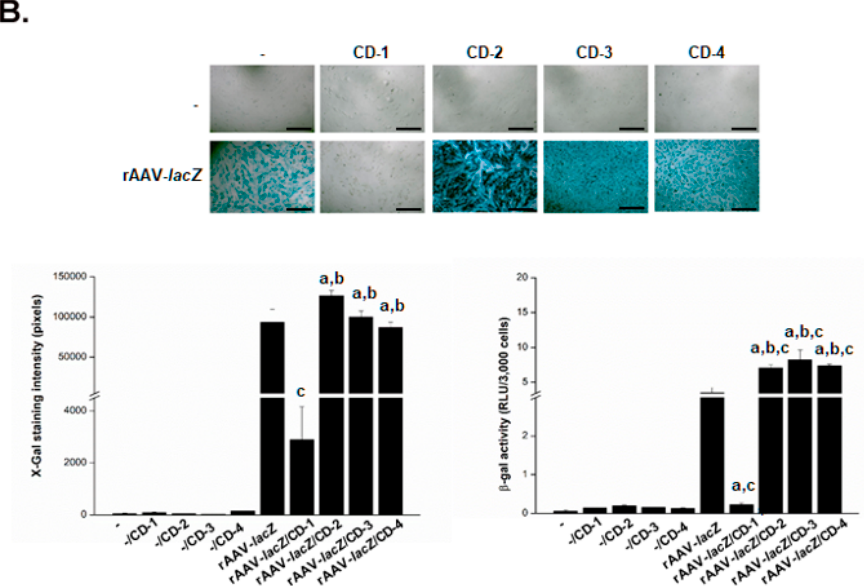
Figure 3. Detection of reporter ( lacZ ) gene overexpression in hMSCs transduced with the rAAV / CD systems. The rAAV- lacZ vector (20 µ L, 4 × 10 5 transgene copies) was formulated with the various CDs (CD-1 to CD-4; 20 µ L), and the resulting rAAV / CD systems (40 µ L, i.e., 4 × 10 5 transgene copies) were incubated with hMSCs (3000 cells in 96-well plates; MOI = 133) for up to 10 days. Expression of lacZ was examined using X-Gal staining (top panel: magnification × 4; scale bars: 500 µ m; all representative data) with corresponding histomorphometric analyses (bottom left panel) and using quantitative estimation of the β -gal activities using the Beta-Glo ® Assay System (bottom right panel) after one ( A ) and 10 days ( B ). Control conditions included CDs lacking rAAV (- / CD), free rAAV (rAAV- lacZ ), and absence of both CD and rAAV (-). Statistically significant relative to a -, b - / CD and c rAAV- lacZ .